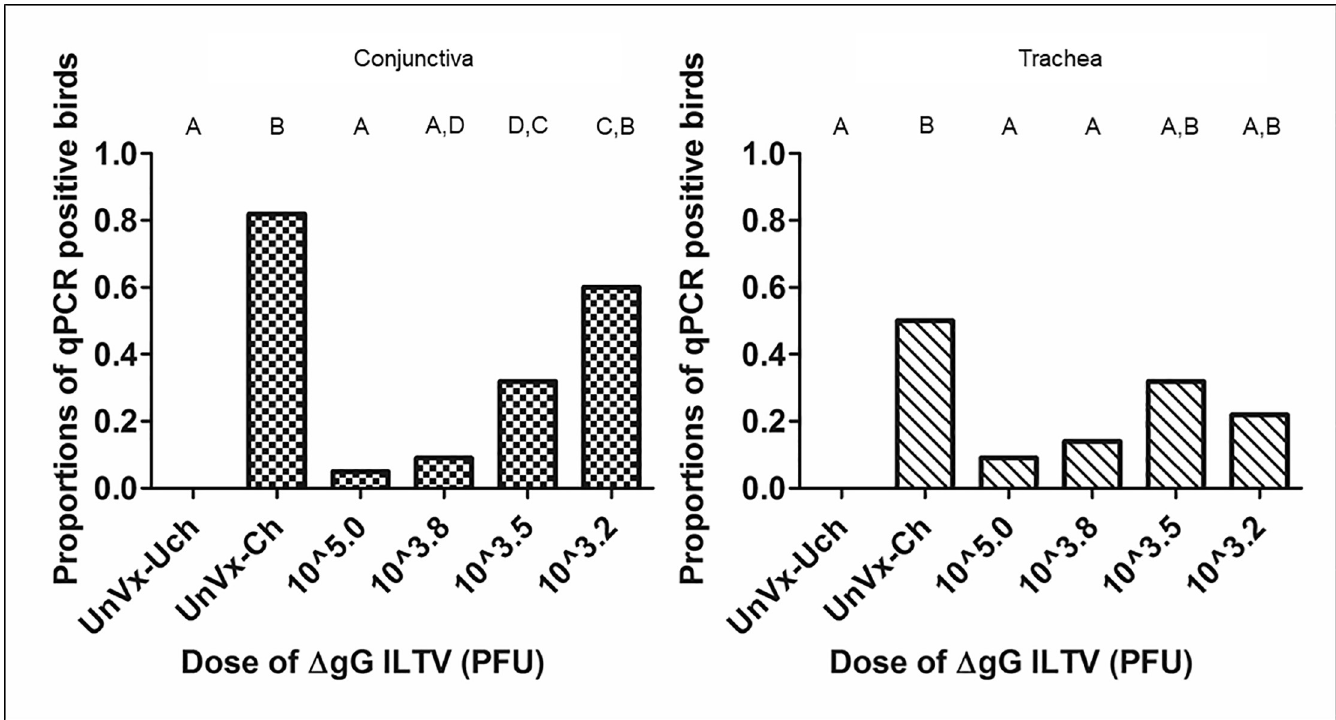
Fig 2. Bar graphs showing proportions of ILTV positive birds per group, as determined by qPCR on extracts from conjunctival or tracheal swabs of unvaccinated birds and birds vaccinated with different doses of Δ gG ILTV at day 7 after challenge with class 9 ILTV. Positivity was determined using the cut-off value of 100 genome copies number per reaction. UnVx-Uch = unvaccinated and unchallenged, UnVx-Ch = unvaccinated and challenged, PFU = plaque forming units. Values labelled with the same upper-case letter (A, B, C, D) were not significantly different (P > 0.05, Fisher’s exact test) in each panel (conjunctiva or trachea).